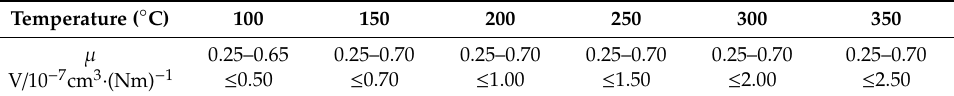
Table 4. Values of friction properties specified in GB 5763-2008.